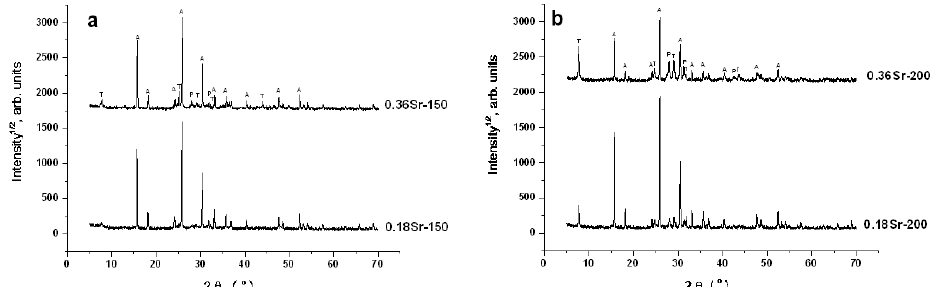
Figure 2. PXRD patterns of products resulting from hydrothermal crystallization in the Sr(NO 3 ) 2 - NaOH-H 2 O-(SiO 2 -Al 2 O 3 ) glass systems at ( a ) 150 °C and ( b ) 200 °C: A—analcime; T—tobermorite; P—plagioclase.